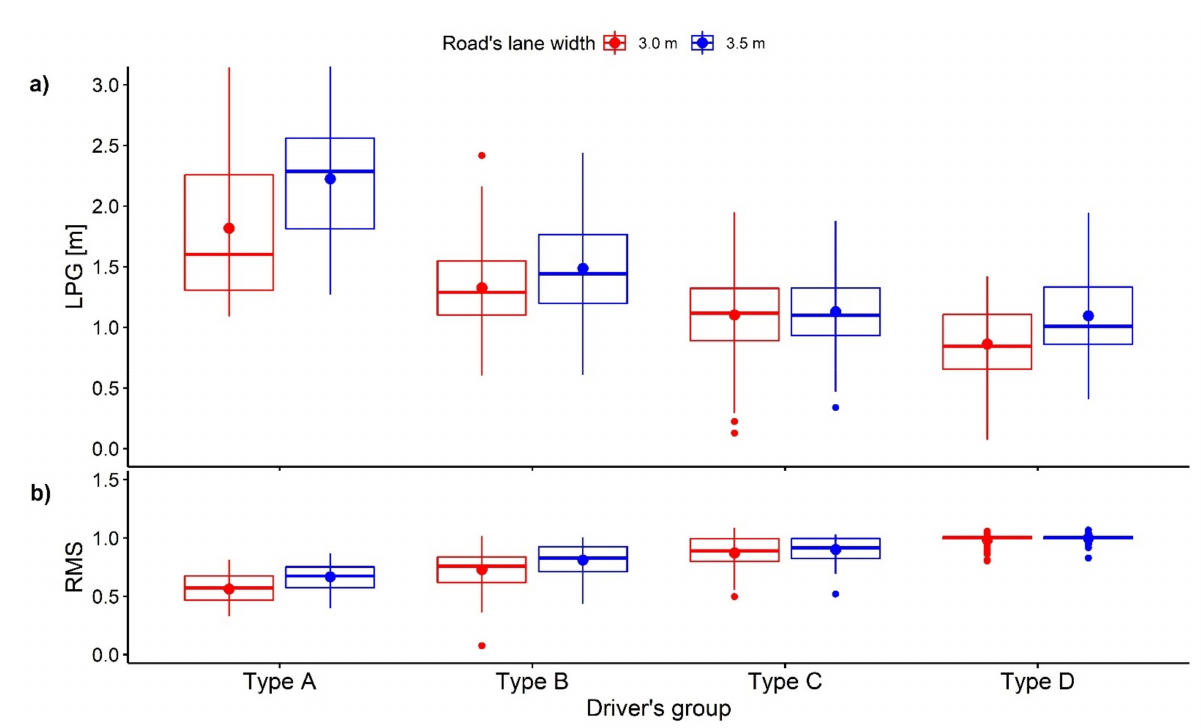
Figure 5. Box plots of the minimum lateral gap while passing VRU ( a ) and the ratio of SV’s minimum velocity to initial speed while approaching VRU ( b ), grouped by road’s lane width between driver’s groups.